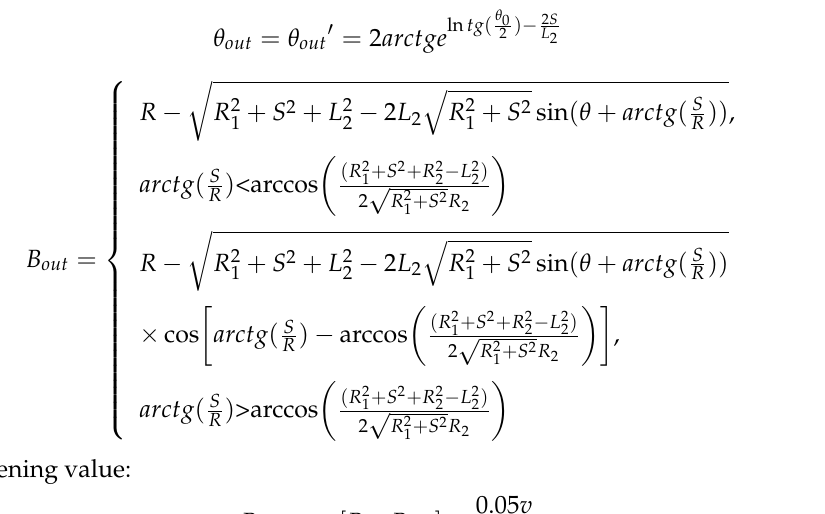
Figure 12. The articulated train drives out of a circular curve. Theoretical model: